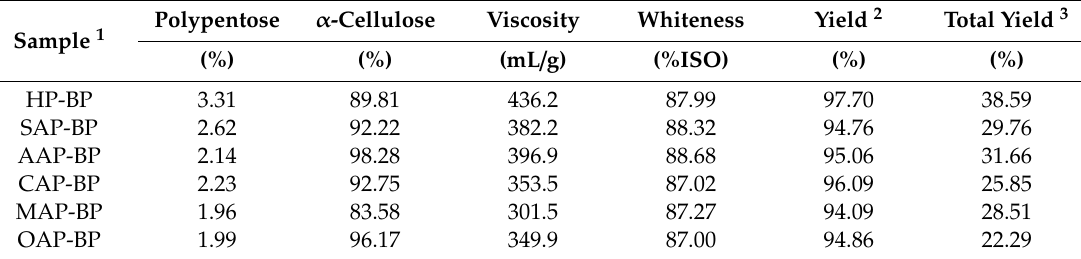
Table 7. Technical specifications of di ff erent dissolving